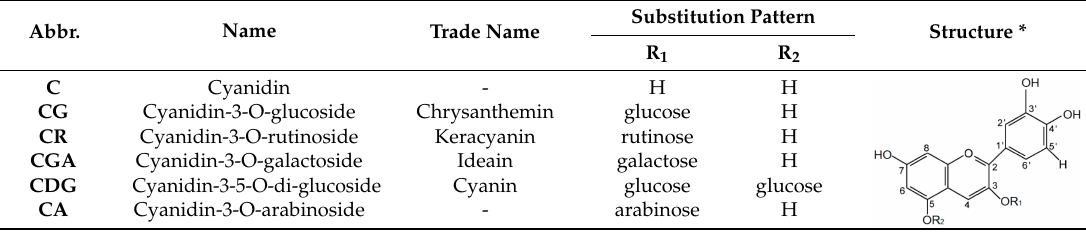
Table 1. Names, trade names, chemical structures and molecular characteristics of cyanidin and its O-glycosides tested in our